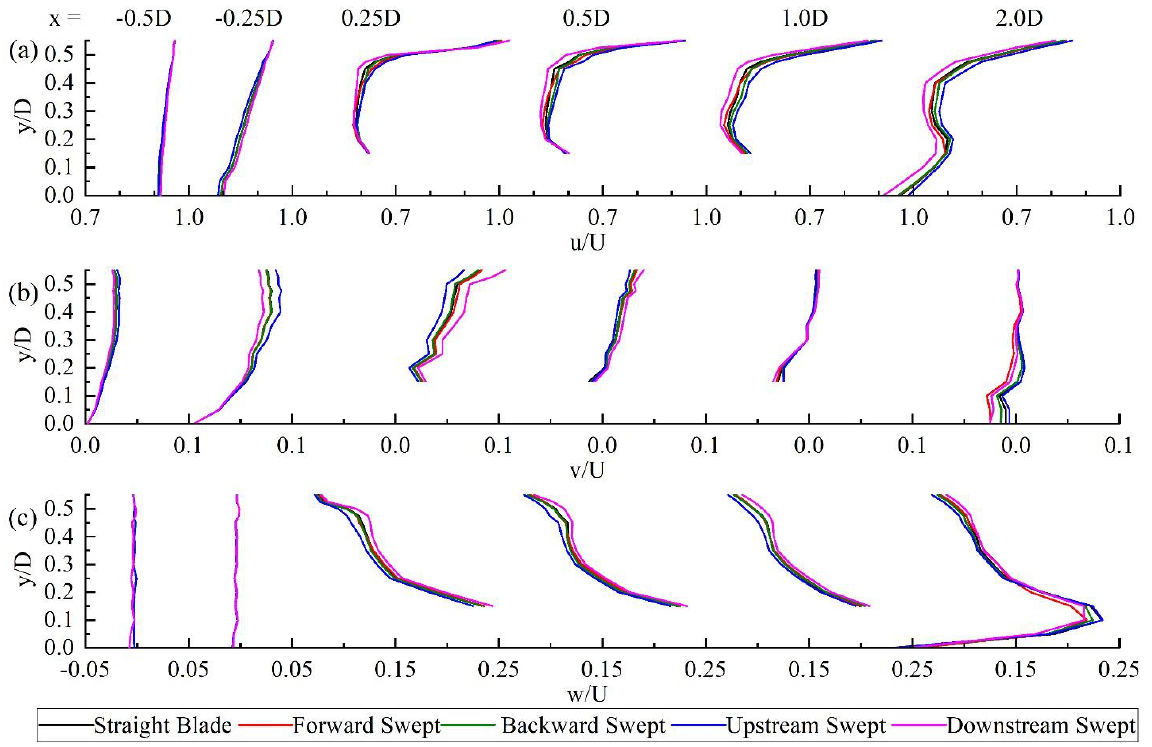
Figure 8. Time-averaged flow velocity distribution at TSR = 6, ( a ) for axial velocity, ( b ) for spanwise velocity, ( c ) for circumferential velocity. velocity, ( c ) for circumferential velocity.